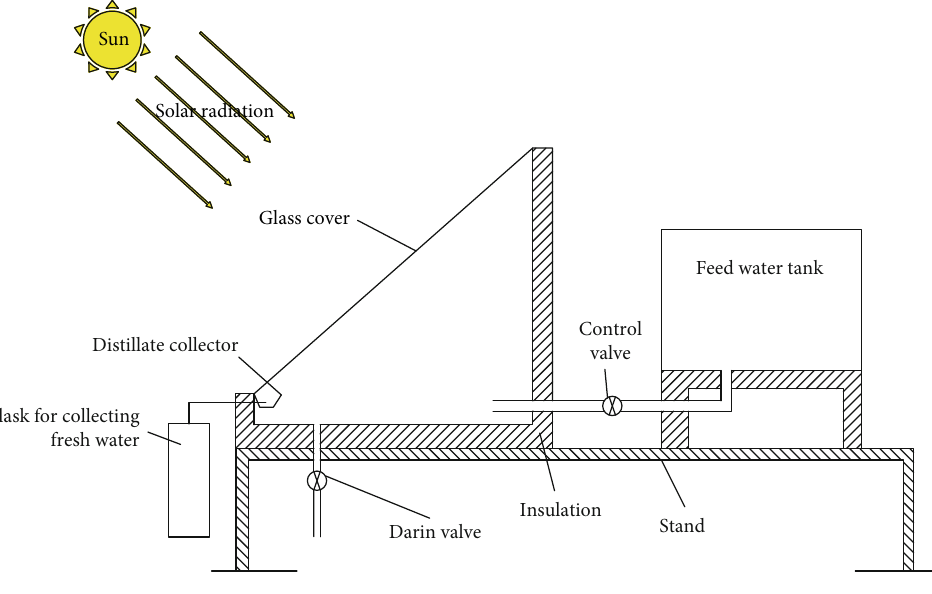
Figure 1: Location of the thermocouples.